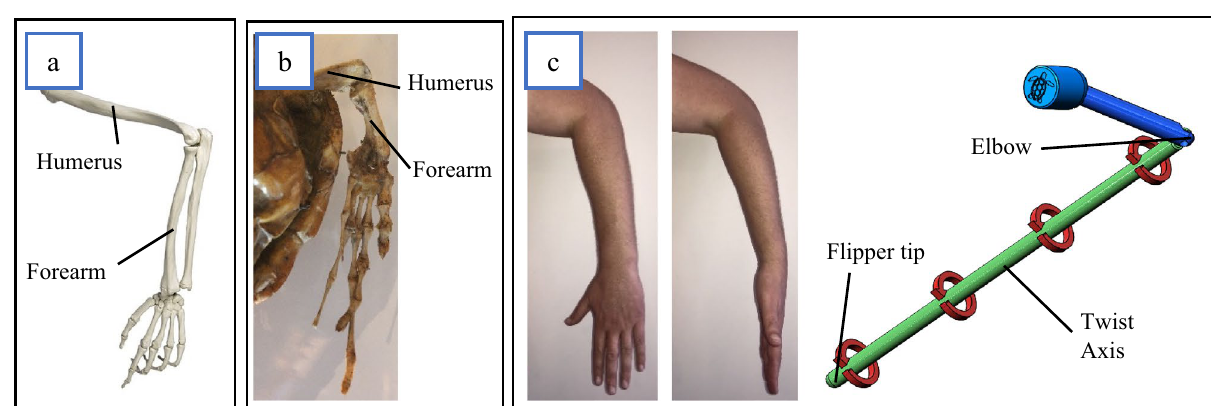
Figure 4. ( a ) Human arm skeleton (created by Henri et George/Shutterstock.com), ( b ) Hawksbill Sea turtle flipper skeleton. ( c ) Forearm rotation